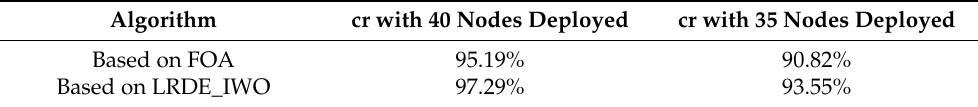
Table 6. Comparison of the optimized coverage results between FOA and LRDE_IWO. Algorithm